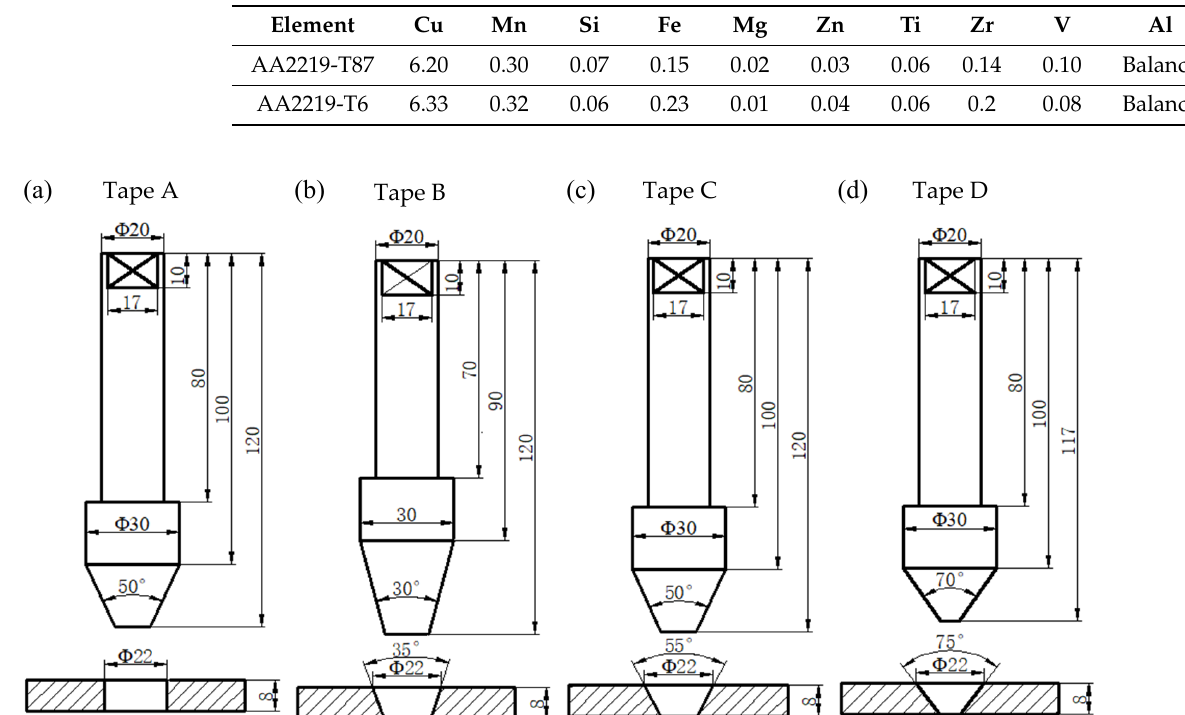
Table 1. Chemical composition of AA 2219 in wt%.